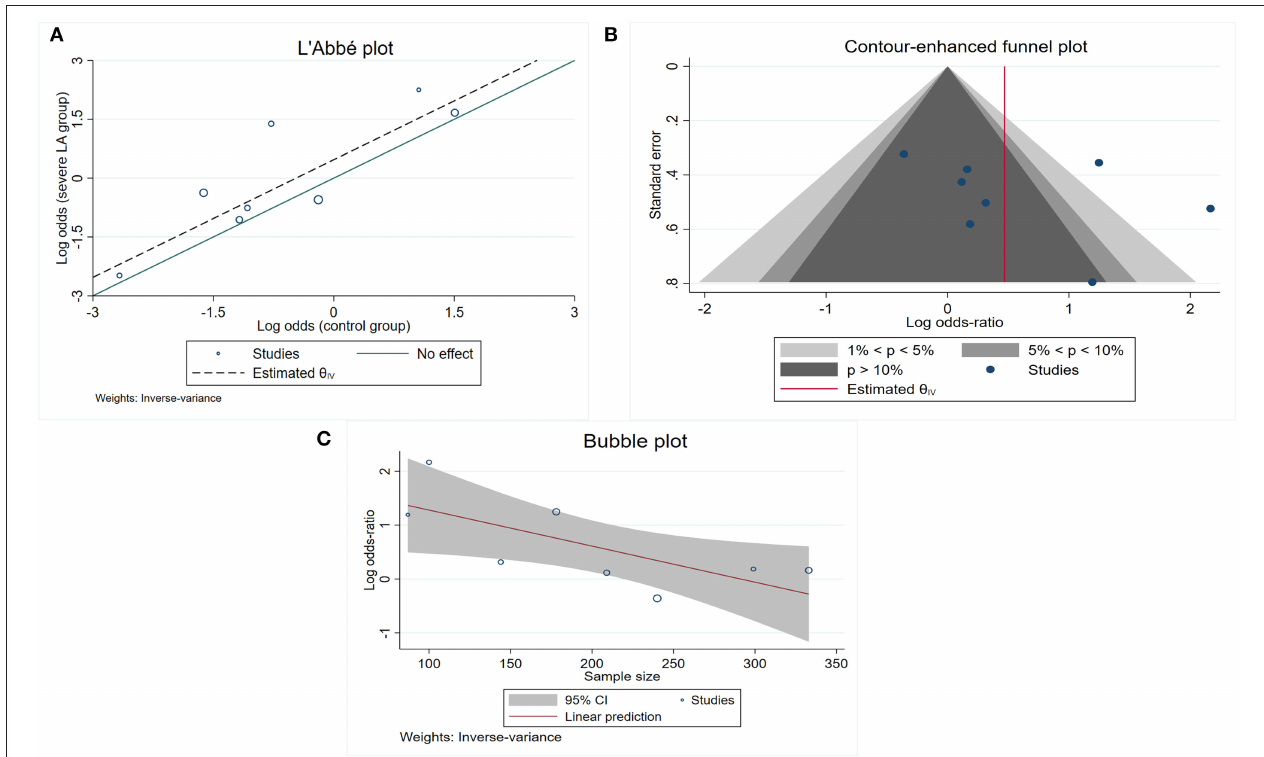
FIGURE 4 | Study characteristics for those included into the association between total LA and poor LC. (A) L’Abb’e plot detects at least 1 study that is far away from the effect-size line (the dashed line); (B) contour-enhanced funnel plot shows that the majority of included studies are nonsignificant, indicating that other factors, other than publication bias, need to be considered for the asymmetry; (C) bubble plot shows that the effect sizes decreased as the number of sample size increased.